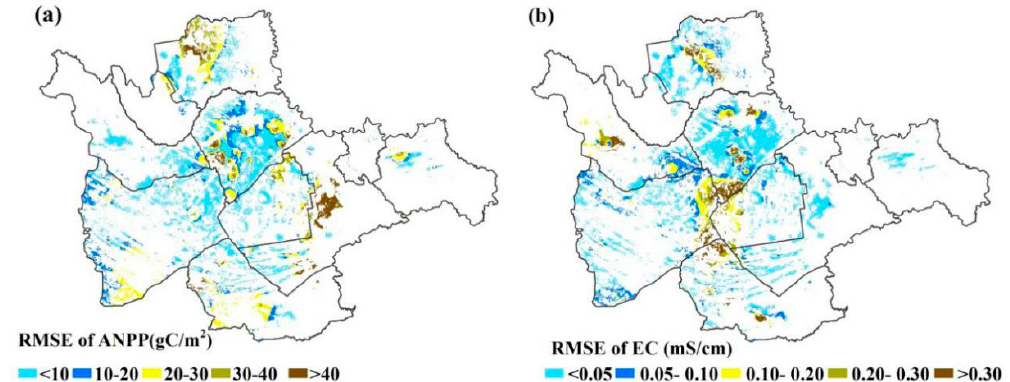
Figure 6. The spatial uncertainties of ANPP and EC models. ( a ) the spatial uncertainty distribution of ANPP; ( b ) the spatial uncertainty distribution of EC.